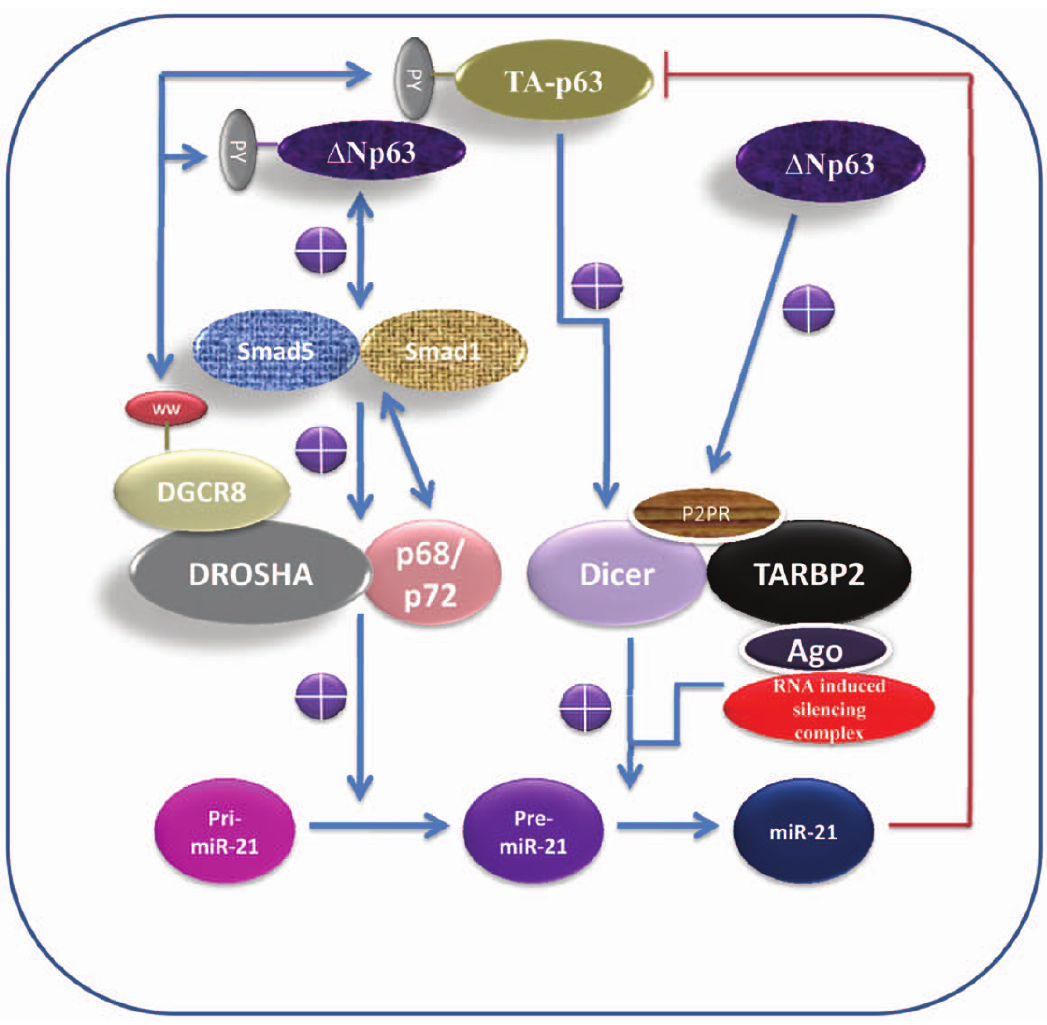
Figure 1. p63 is a regulator of microRNA-processing pathway.